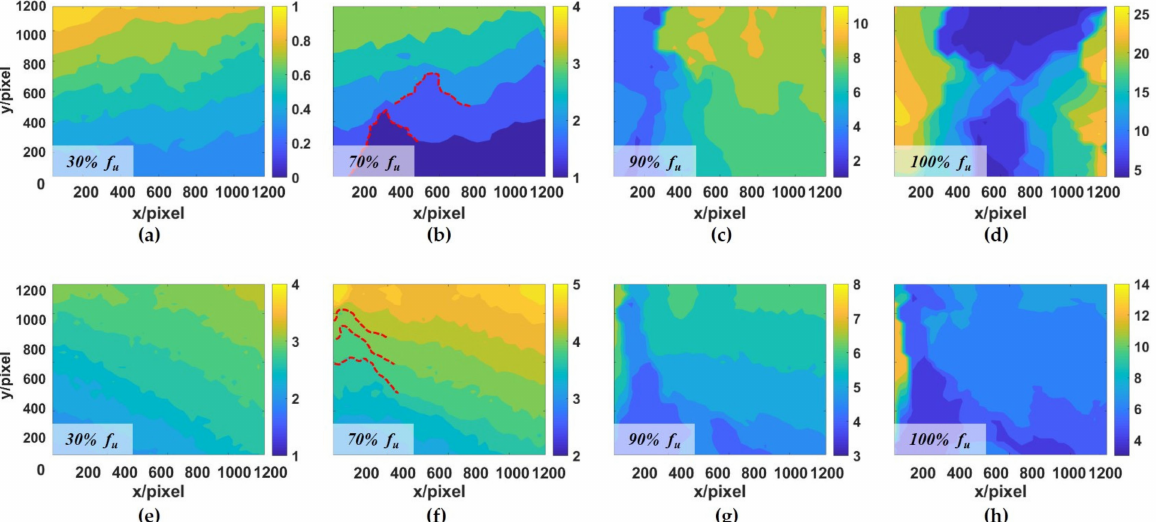
Figure 4. Full-field displacement of OPC (ordinary Portland cement)-based seawater concrete at four loading stages of 30% f u , 70% f u , 90% f u and 100% f u ( f u denoted the peak load of concrete). ( a – d ) Displacement fields of OPC-based concrete cured in freshwater condition (denoted as OPC-F); ( e – h ) Displacement fields of OPC-based concrete cured in seawater condition (denoted as